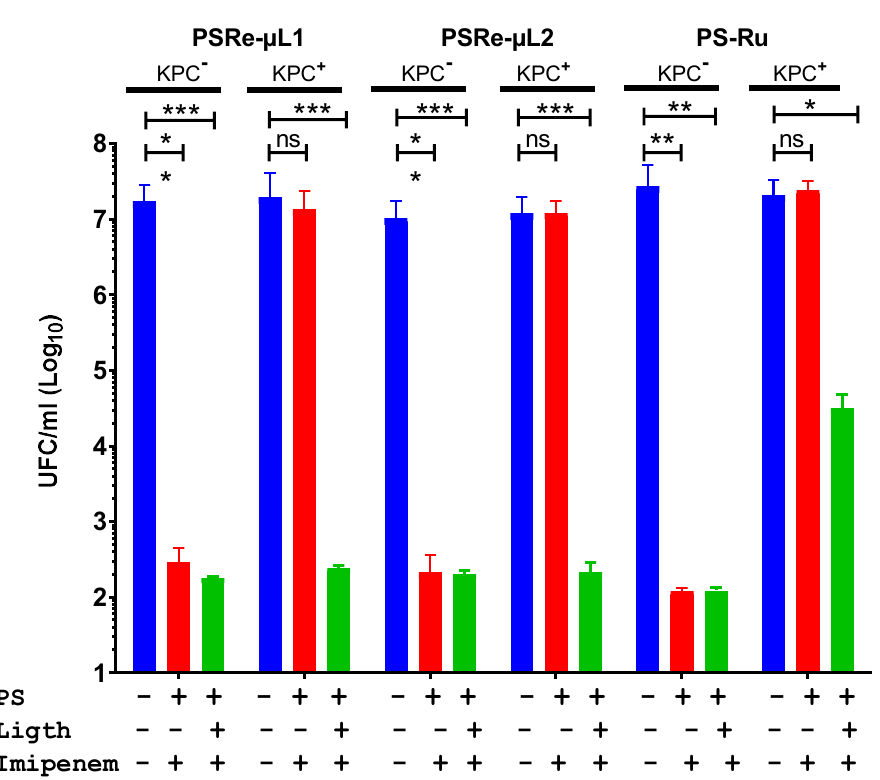
Figure 4. Increased photodynamic effect with imipenem. The effect of carbapenem on the PSRe-µL1 and PSRe-µL2 activity was determined in the strains of K. pneumoniae sensitive (KPPR1) or resistant (ST258) to imipenem. The bacteria at 1 × 10 7 UFC/mL were exposed to a mixture of 4 µg/mL of imipenem and with 4 µg/mL of each PS or the control PS-Ru. For aPDI treatment, the mixes were incubated for 1 h at 17 µW/cm 2 of light (green bars) or in the dark (red bars). Control also includes bacteria not treated (blue bars). Colony count enumerated viable bacteria on ca-MH agar after serial microdilution. The CFU/mL values are presented as means ± SD on a log 10 scale. The + and - signs indicate the presence or absence of a compound or condition. Not significant (ns) p > 0.05 by Student’s t -test among bacteria treated with PS + imipenem without light compared to untreated control bacteria; * p < 0.05, ** p < 0.01 *** p < 0.001 by Student’s t -test among bacteria treated with PS + imipenem exposed to light compared to untreated control bacteria.